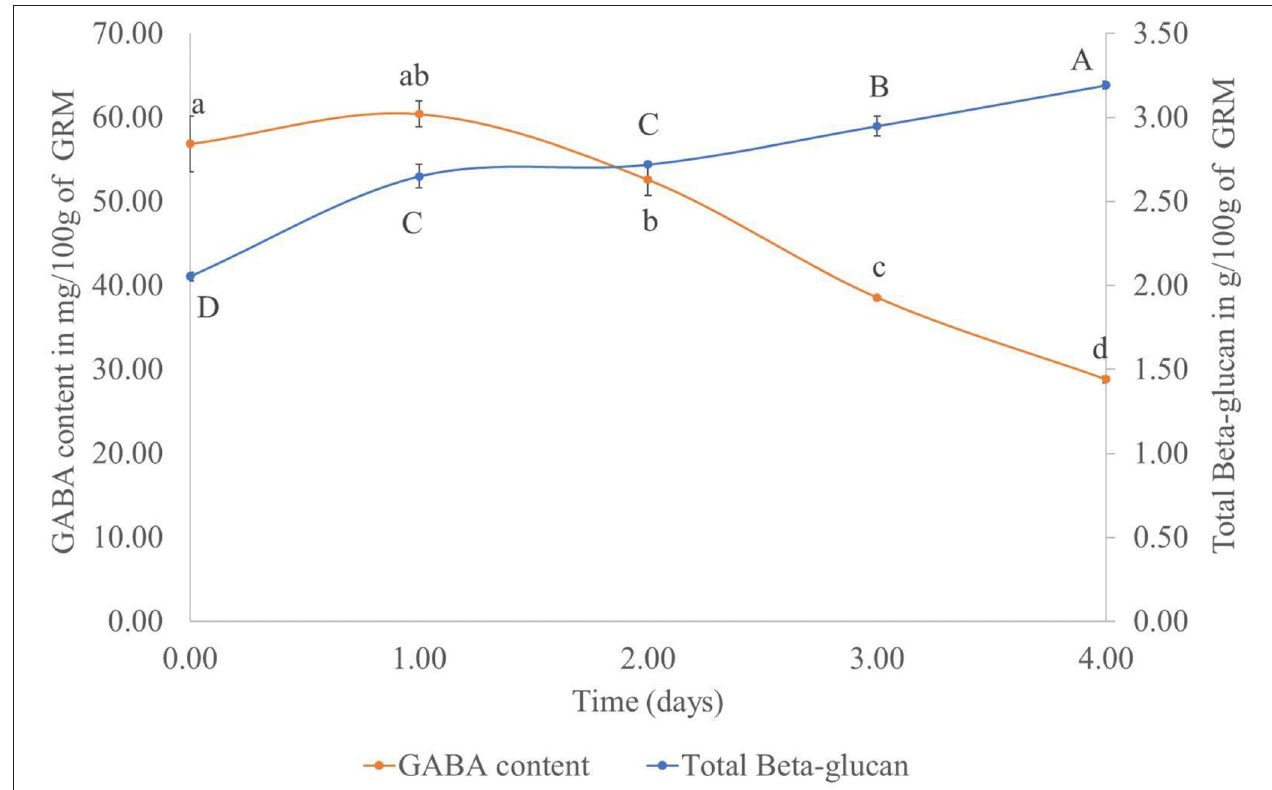
FIGURE 2 | Total β -glucan and GABA contents (mg/100g sample) in germinated rice with mycelium of Pleurotus ostreatus from day 0 to 4. Points with the same superscript on the same line were not significantly different ( p > 0.05).